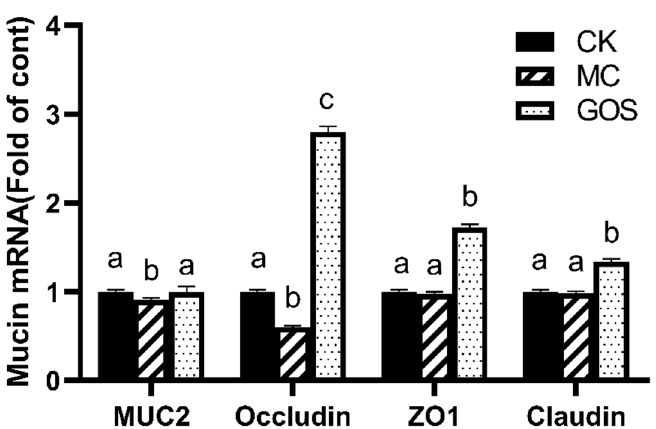
Figure 5 . Relative mRNA levels of mucins, all normalized to β -actin mRNA expression. Different letters (a–c) are used to express the significant difference ( p < 0.05) of the same factor among groups.